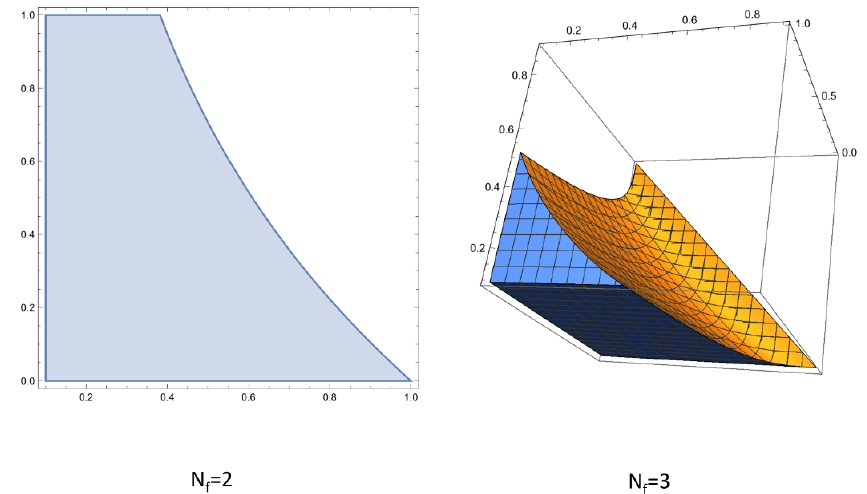
Figure 6 . CP conserving ((cid:12)lled) and CP breaking (empty) regions for N f = 2 and N f = 3. The vertical axis is D , the horizontal is (are) the mass